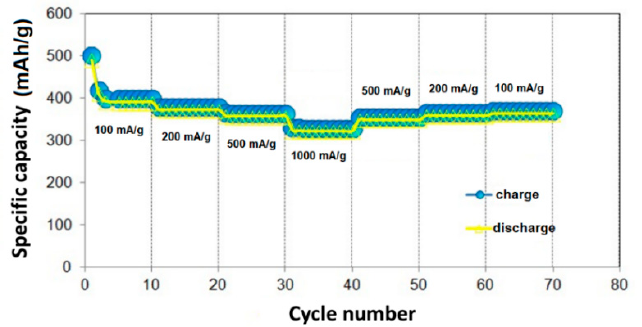
Figure 9. Rate performance from 100 to 1000 mA/g for the Ti5Mo5 sample.